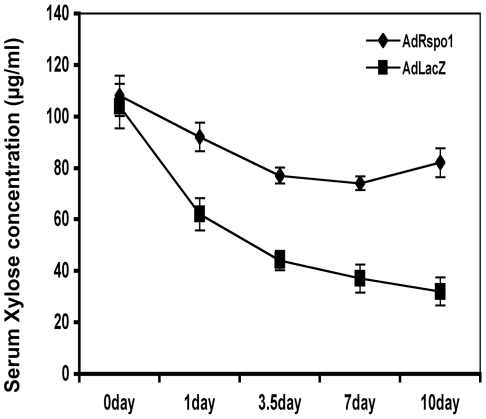
Xylose absorption assay.A time course study (1–10dys) showed significant recovery (p<0.002) of xylose absorption at 3.5 to 7 days in AdRspo1-treated cohorts, when compared to AdLacZ controls, thereby indicating the functional regeneration of intestine after radiation injury. AdLacZ-treated animals were incapable of demonstrating adequate xylose absorption after radiation injury, further contributing to animal mortality.